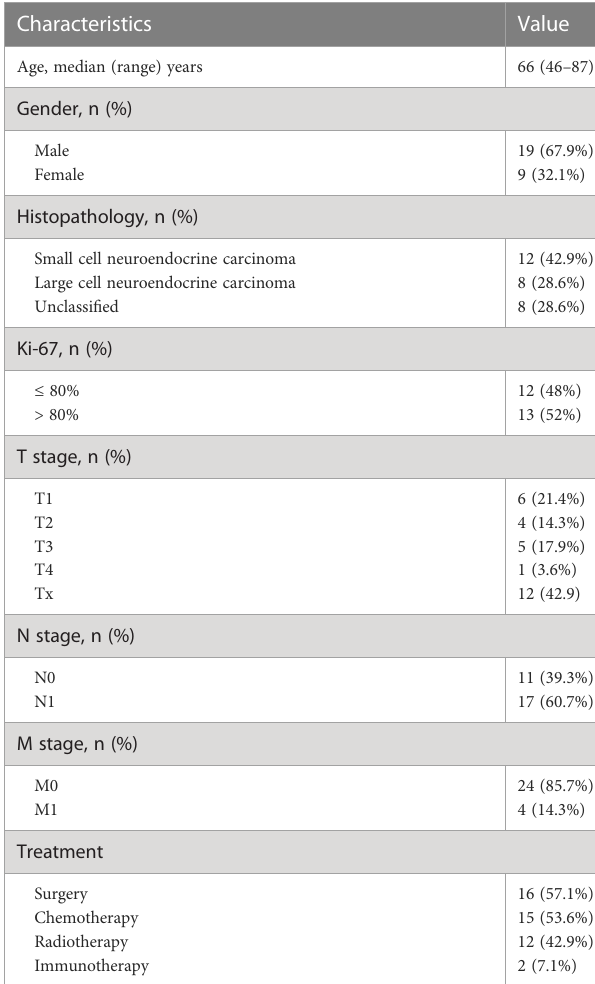
TABLE 1 Baseline characteristics of